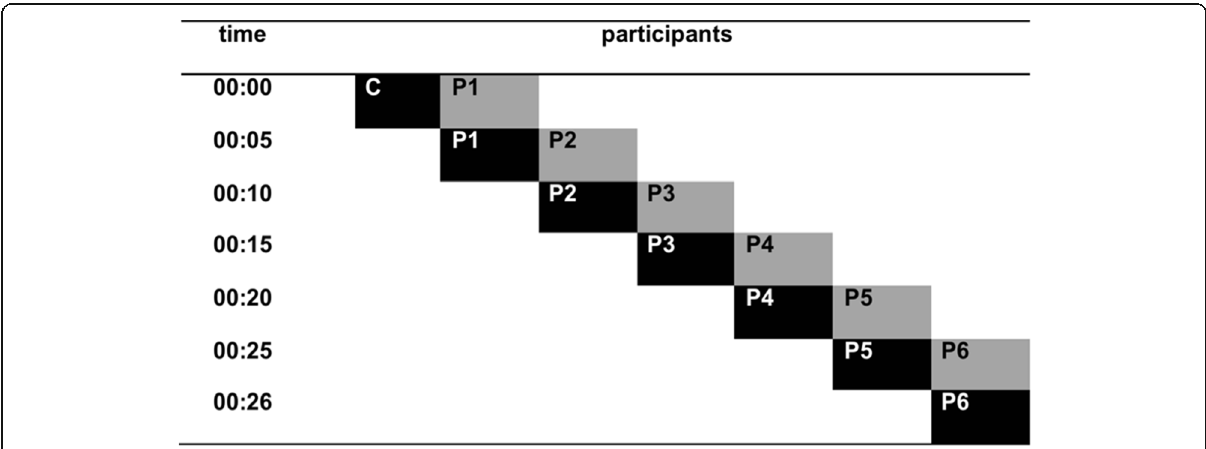
Fig. 2 Replacement procedure for each chain of participants. Black rectangles represent participants who worked on the computer task. Gray rectangles represent participants who were observers. Once a participant completed the task, the observer began working on the task and another participant became an observer, and so on, until the last participant in the chain. C confederate, P